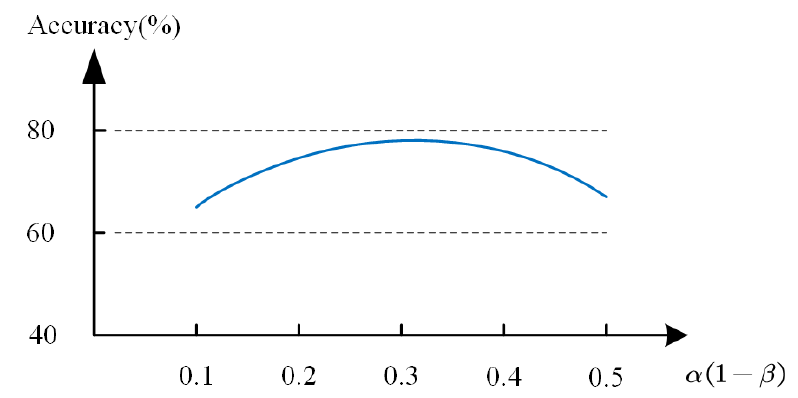
Figure 3. Accuracy of the model on a subset of ARSC with different values of α and β .